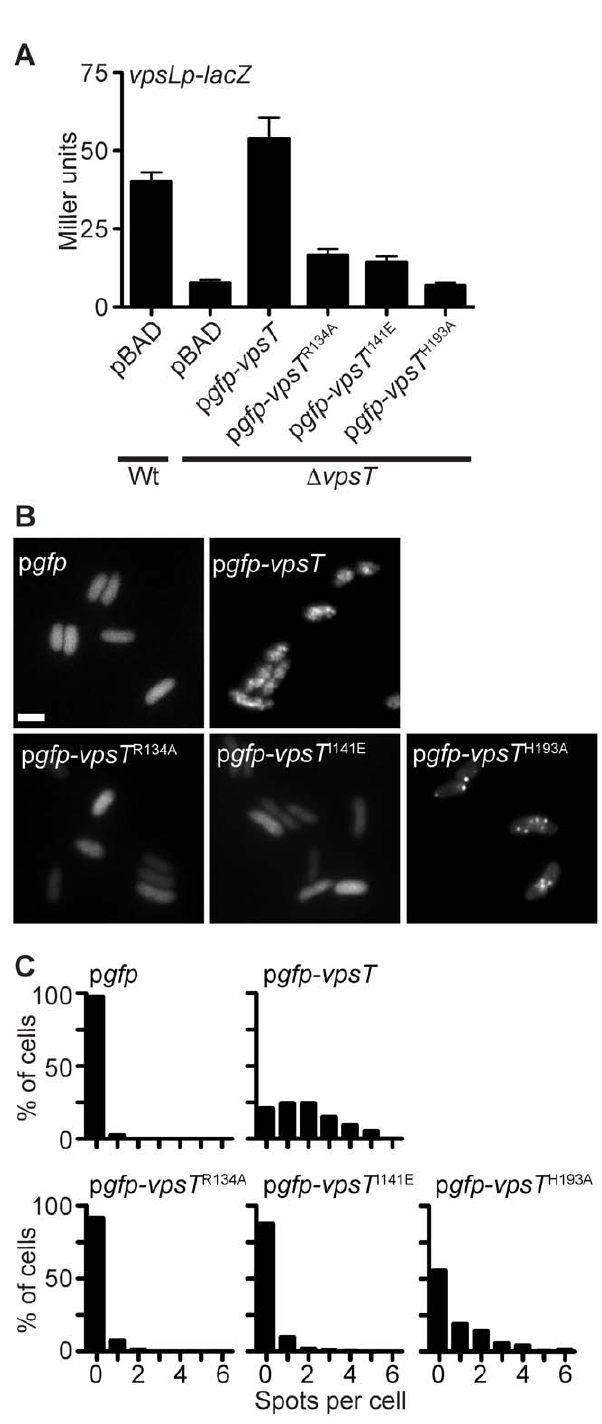
Figure 3. The Subcellular Localization of VpsT is Dependent on c-di-GMP Binding and DNA Binding Residues. (A) The expression of a chromosomal vpsL promoter- lacZ fusion was measured in wild type (Wt) or D vpsT strains containing pBAD vector alone, or pBAD containing gfp fused to wild type and mutated versions of vpsT using b - galactosidase assays. A R134A mutation disrupts c-di-GMP binding and an I141E mutation abolishes c-di-GMP-dependent dimerization. H193A lies in the DNA binding domain of VpsT. (B) Subcellular localization of GFP, GFP-VpsT or GFP-VpsT containing the indicated point mutations, expressed in V. cholerae D vpsT . Representative epifluorescence micrographs are shown. Marker is 2 m m. (C) Single- cell quantification of subcellular fluorescence localization. The